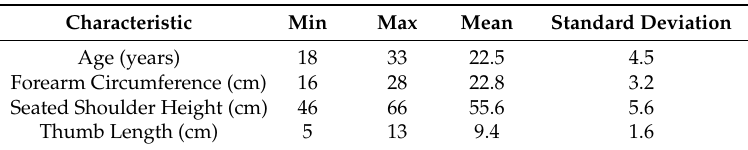
Table 1. Subject characteristics.